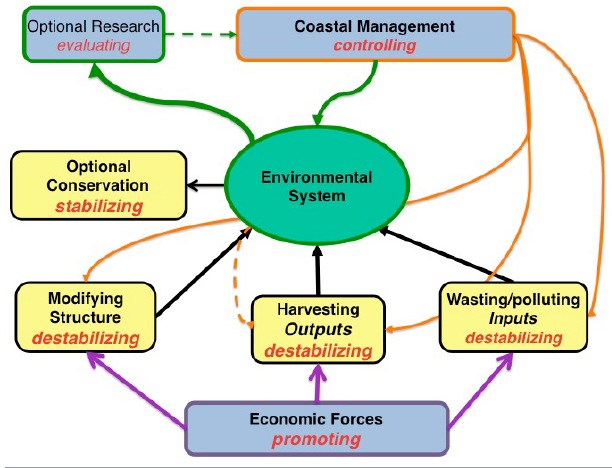
Fig. 2. Human activities in most coastal zone systems lack functional feedback loops with the environment that they are impacting. This requires that either policy regulate these activities, or that the activities themselves become sustainably self-regulating, i.e., with regard to their impacts on natural and social subsystems of a coastal system. The black arrows designate the human activities that use the environmental system. The solid orange lines indicate the indirect feedback loops that policy might establish for the three categories of destabilizing human activities, and the orange dotted line is an additional potential direct feedback for Harvesting. The dark purple arrows indicate market influences on the human activities. The dark green arrows are the potential information feedback loop of the